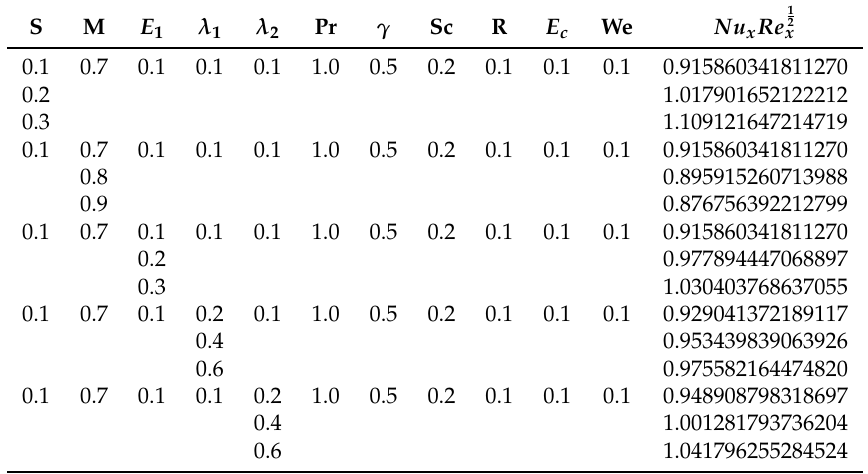
Table 2. The numerical values of Nu x Re Pr , R , E c , γ and Sc when η =